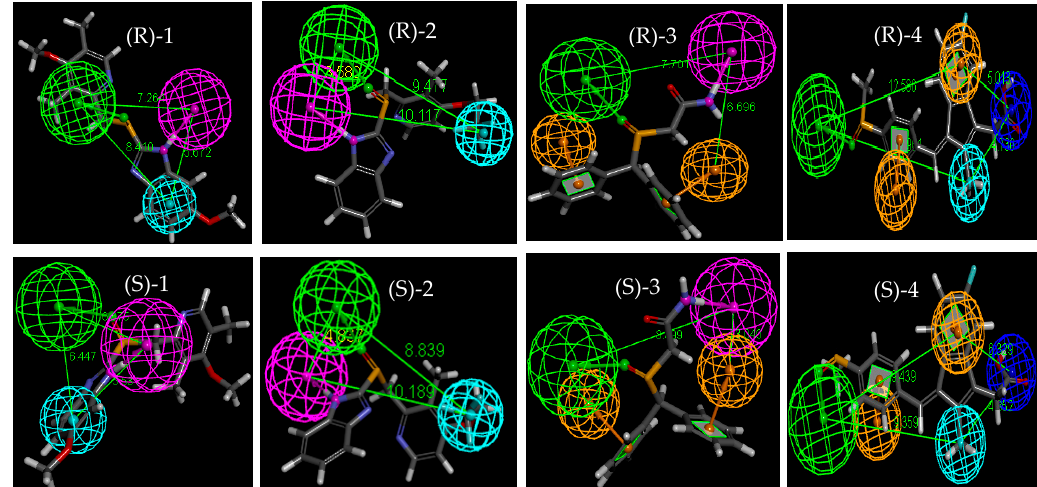
Figure 4. Pharmacophores of 1 – 4 conformers over the most populated cluster. HBA: green, HBD: purple, HY: light blue, AR: orange, NI: mazarine.